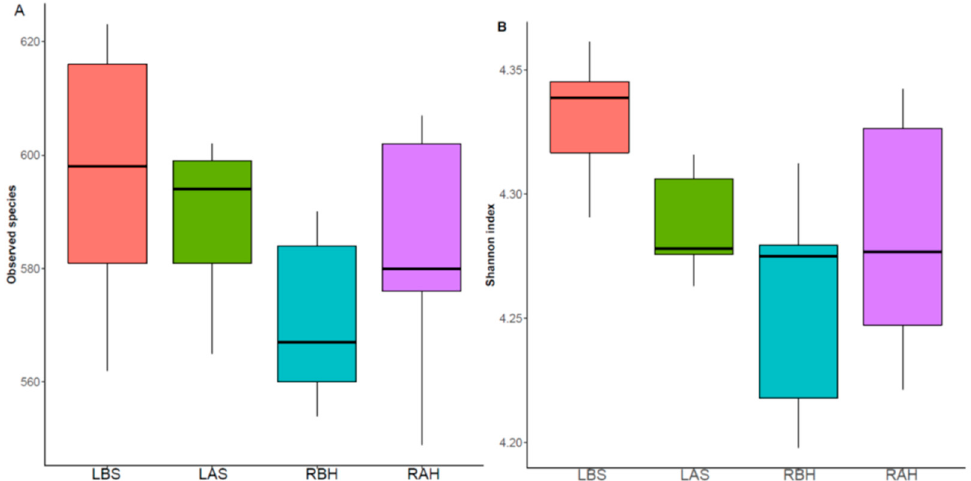
Figure 4. Comparison of alpha diversity of the nasal microbiome before and after honey and saline treatment in atrophic rhinitis patients using an ANOVA test based on ( A ) observed OTUs ( p = 0.29) and ( B ) Shannon index ( p = 0.057) metrics.